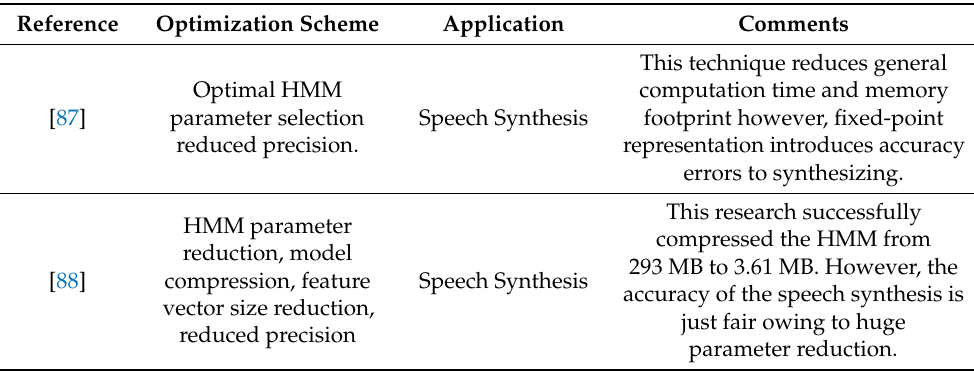
Table 4. Optimization Schemes for